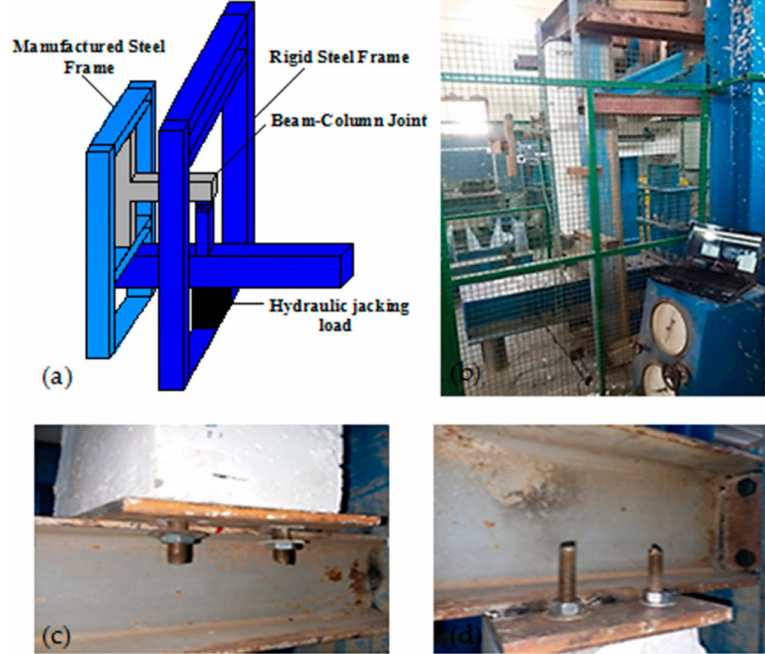
Figure 4. Testing machine. ( a ) Testing frames, ( b ) supports of the specimen. ( c ) Bottom end of the RC column, ( d ) upper end of RC